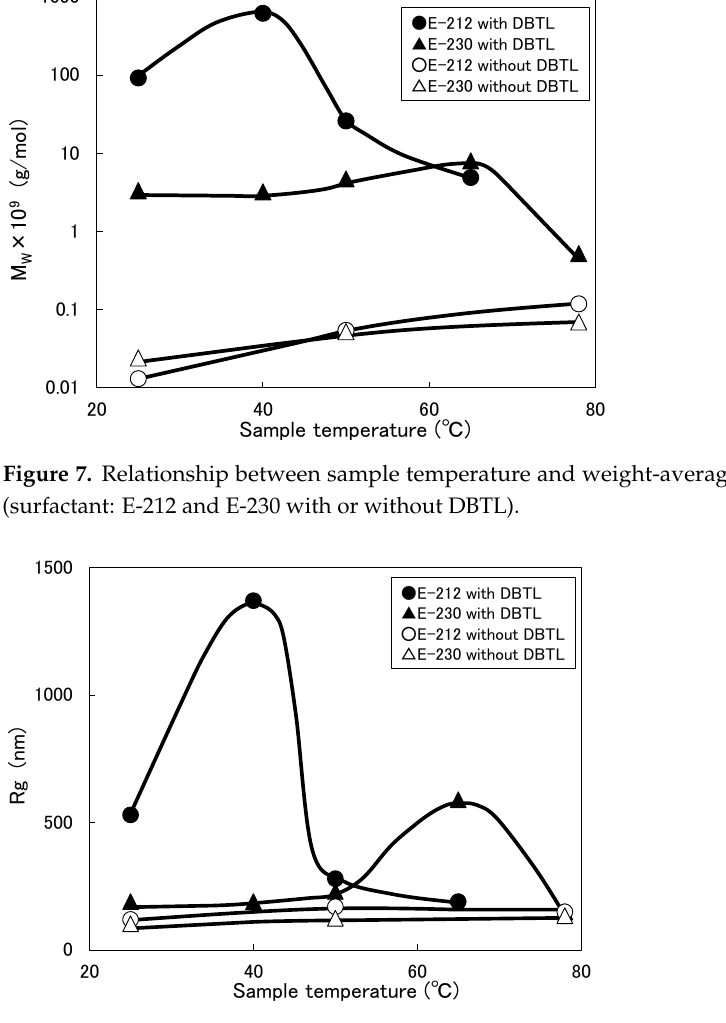
Figure 8. Relationship between sample temperature and inertial radius (Rg) (surfactant: E-212 and E-230 with or without DBTL).